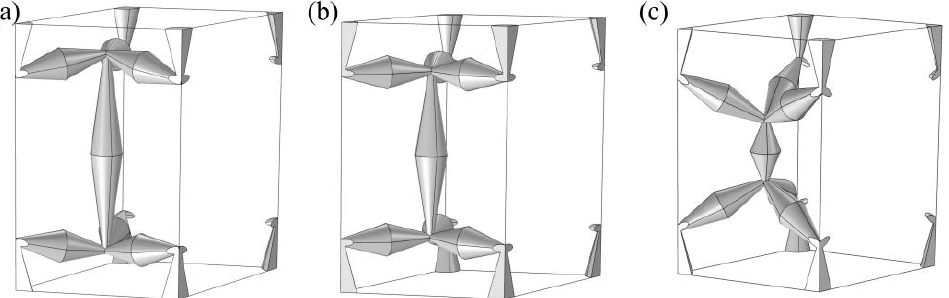
only compressional modes exist. Four specific modes along the Γ M direction are shown in Figure 4b. The compressional mode is accompanied with shear modes at all frequencies. Figure 2. The variation in the primitive cell by moving P 1 and P 2 vertically with ( a ) η v < 0 ( b ) η v = 0 ( c ) η v > 0.